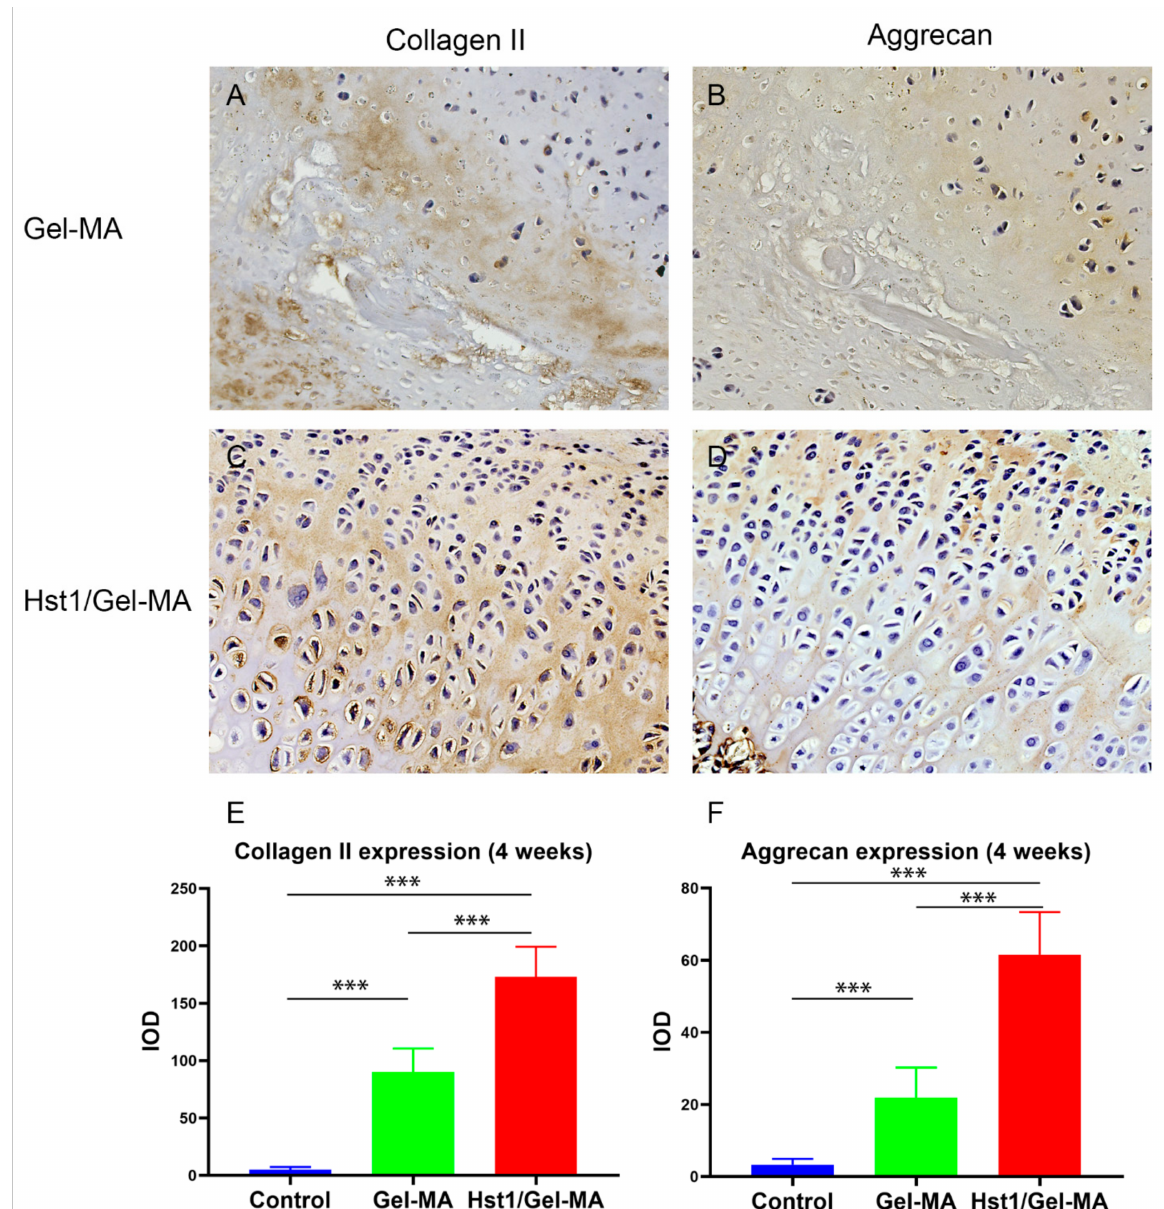
Figure 7. Light micrographs of immunohistochemically stained tissue sections of collagen II ( A , C ) and aggrecan ( B , D ) in the Gel-MA group ( A , B ) and Hst1/Gel-MA group ( C , D ). The tissues were retrieved at 4 weeks postoperation and then subjected to immunohistochemical processing and sectioning. Quantitative analysis of collagen II ( E ) and aggrecan ( F ) expression at 4 weeks. Scale bar = 100 µ m in A – D . ( n = 6, *** p <